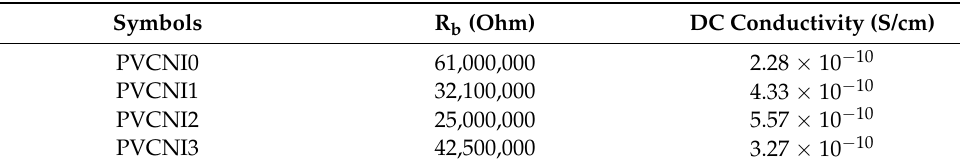
Table 1. DC conductivity of the systems at RT.